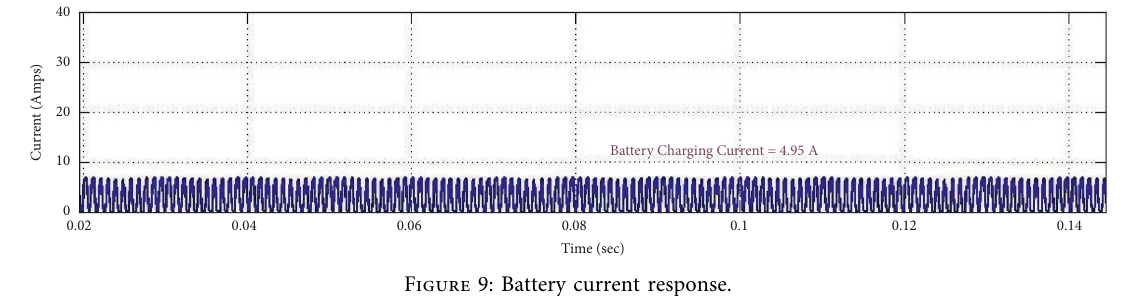
Figure 9: Battery current response.